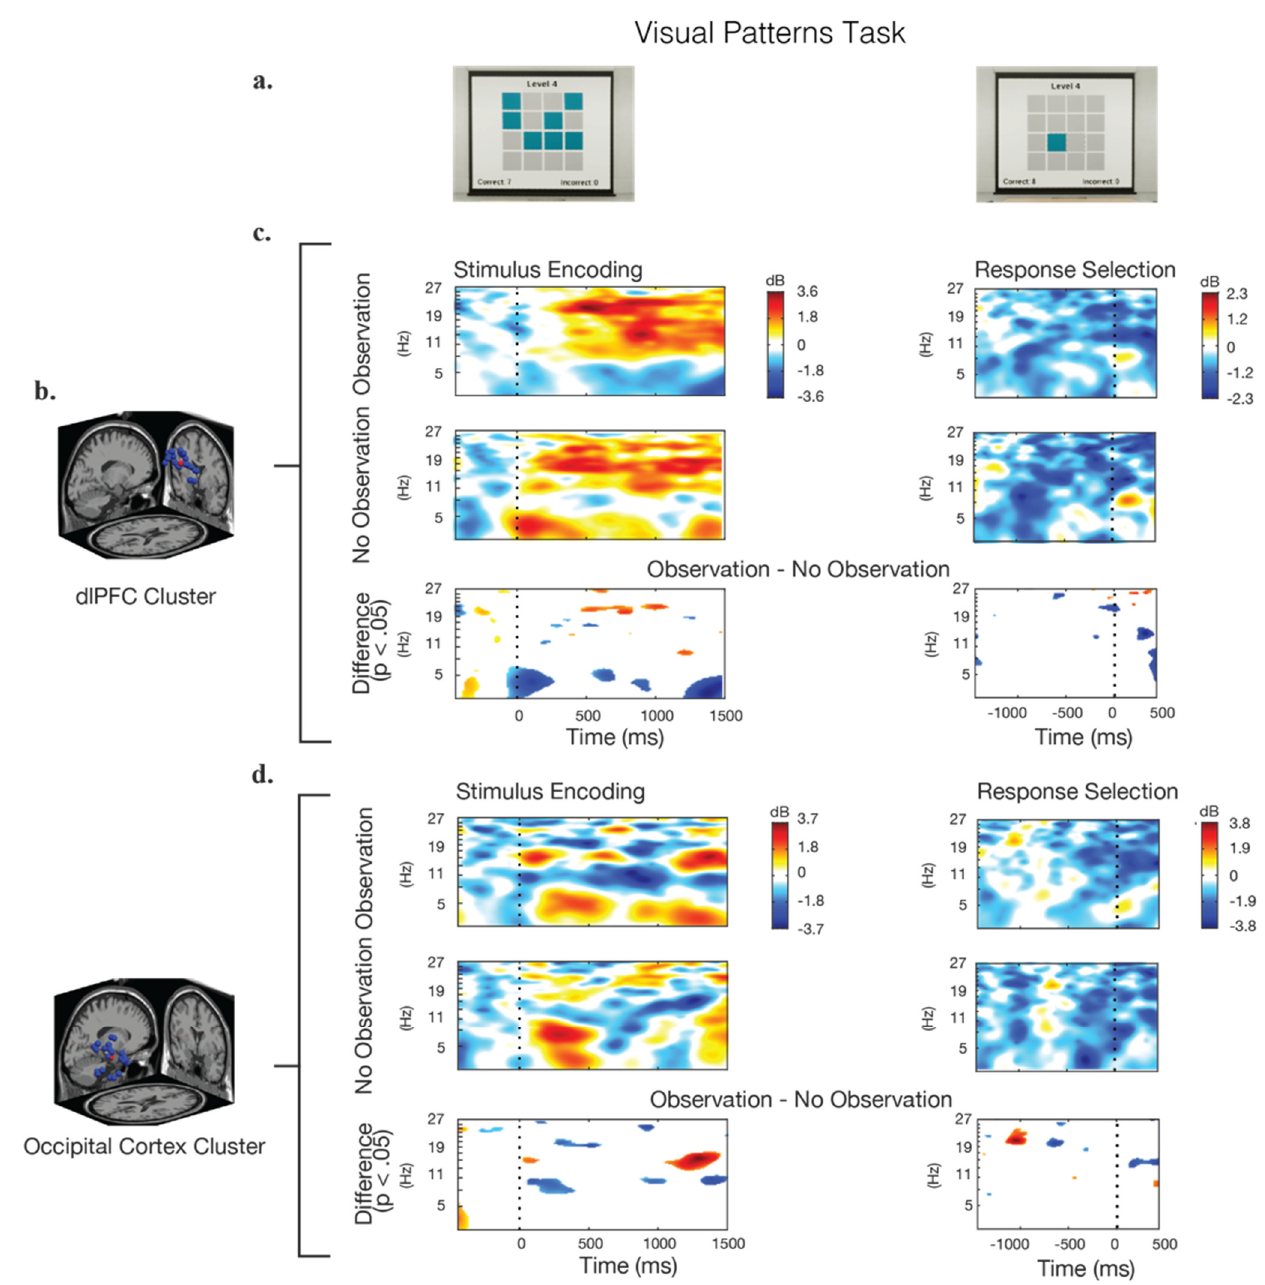
Figure 5. Event-related spectral perturbations (ERSP) during the stimulus presentation and response epochs for the visual pattern test. ( a ) Screenshot examples of the visual stimulus and response options. ( b ) The IC clusters selected for analysis were located in the dorsolateral prefrontal cortex (dlPFC) and the occipital cortex (OC); the locations of the individual IC dipoles are shown in blue and the equivalent dipole location is shown in red. ( c , d ) Calculated ERSPs for the observation condition, the no-observation condition, and their significant differences. Frequency power is baselined to the beginning of the trail. Blue regions in the difference-graphs indicate that the observation condition showed significantly lower power, while red regions indicate that the observation condition showed significantly higher power.